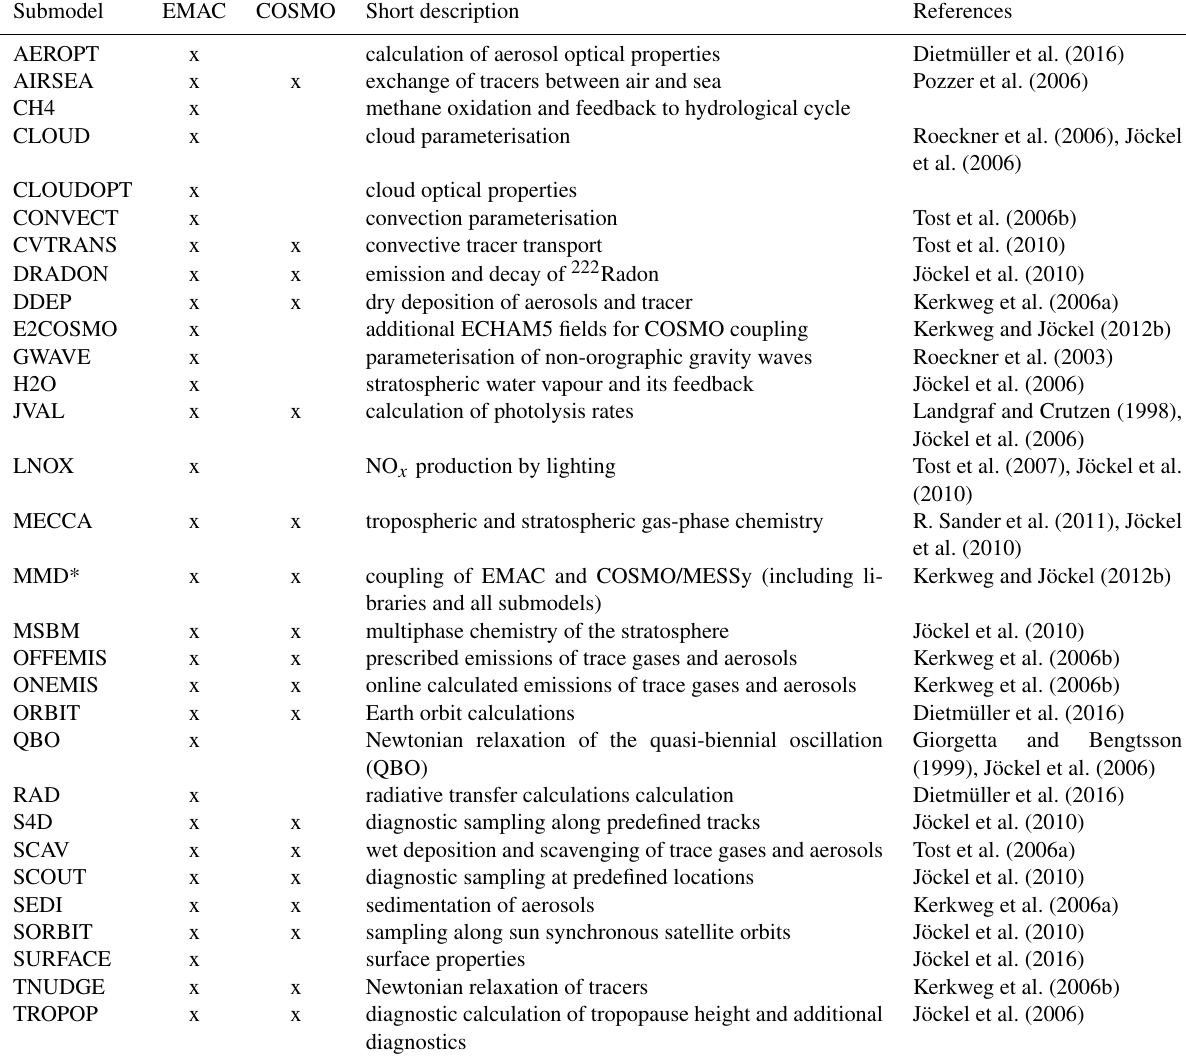
Table 1. Overview of the most important submodels applied in EMAC and COSMO/MESSy, respectively. Both COSMO/MESSy instances use the same set of submodels. The complete list can be found in the Supplement (Sect. 6). MMD ∗ comprises all MMD